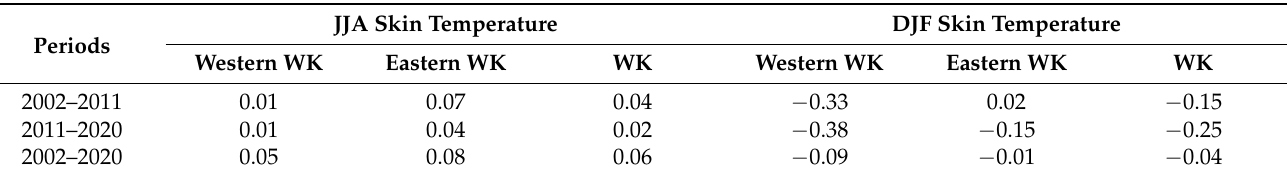
Table 6. June-July-August (JJA) and December-January-February (DJF) skin temperature (unit: °C a − 1 ) trends in western WK, eastern WK and WK overall, over three time